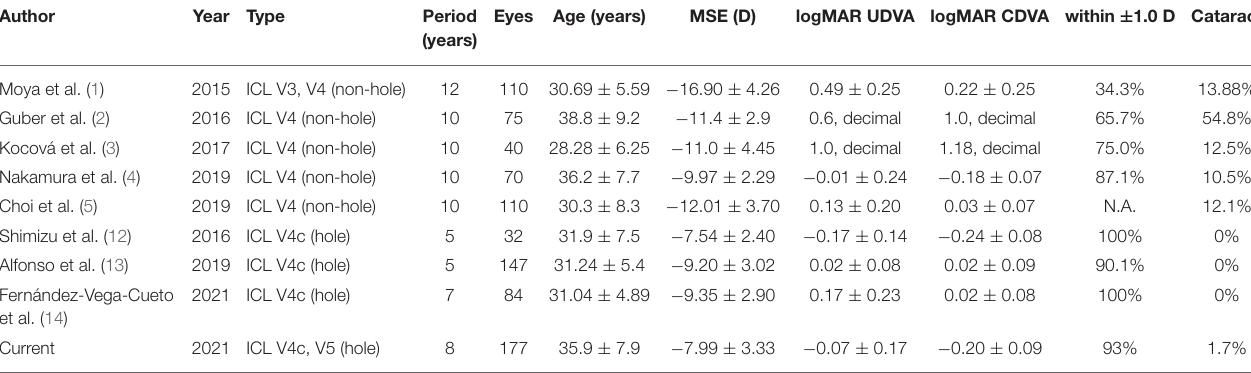
TABLE 3 | Summary for long-term outcomes of conventional implantable collamer lens implantation (spanning 10 years or more) and hole implantable collamer lens implantation (5 years or more) for myopia.